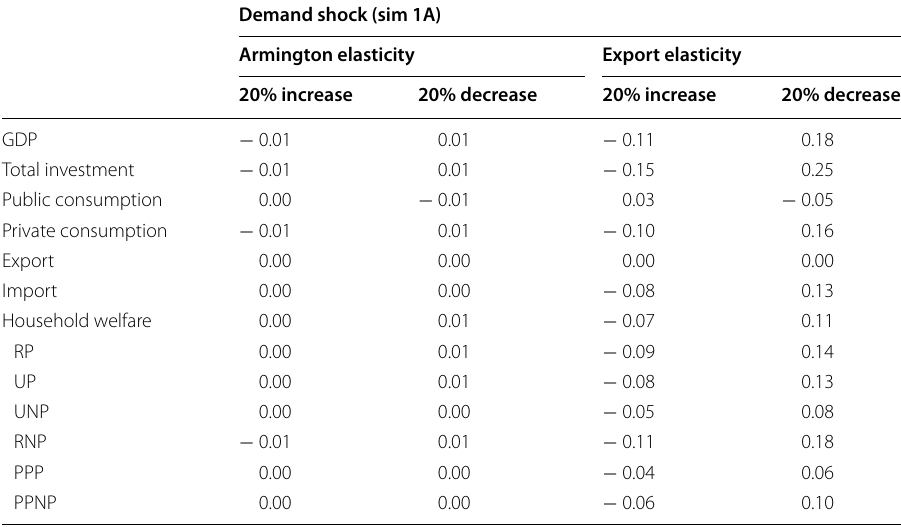
Table 11 Sensitivity analysis for Armington and export elasticity (changes from base